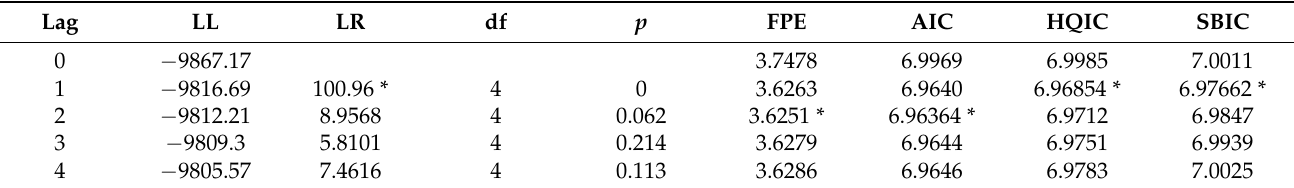
Table 2. Lag order test for WTI and AFI .